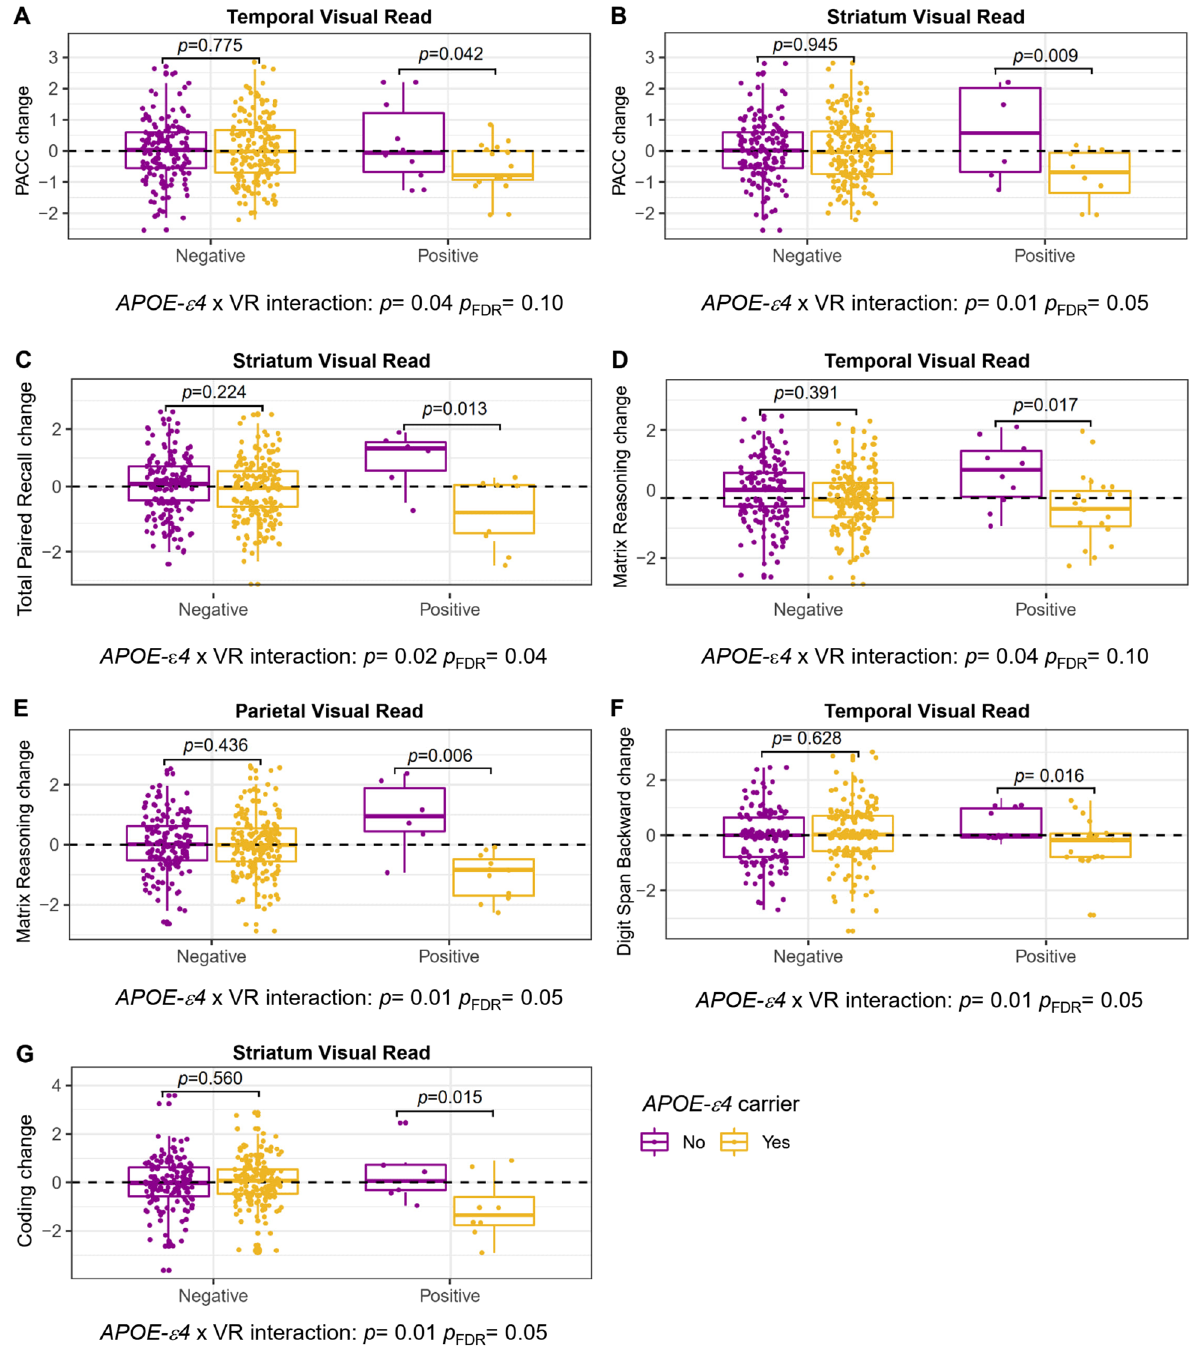
Fig. 2 Cognitive change in regional Aβ PET visual read by APOE-e4 status. Boxplots showing the annualized cognitive change residuals (adjusted by sex, age, education, and baseline score). P ‑values for pairwise comparisons are provided. The dashed line represents stable performance.